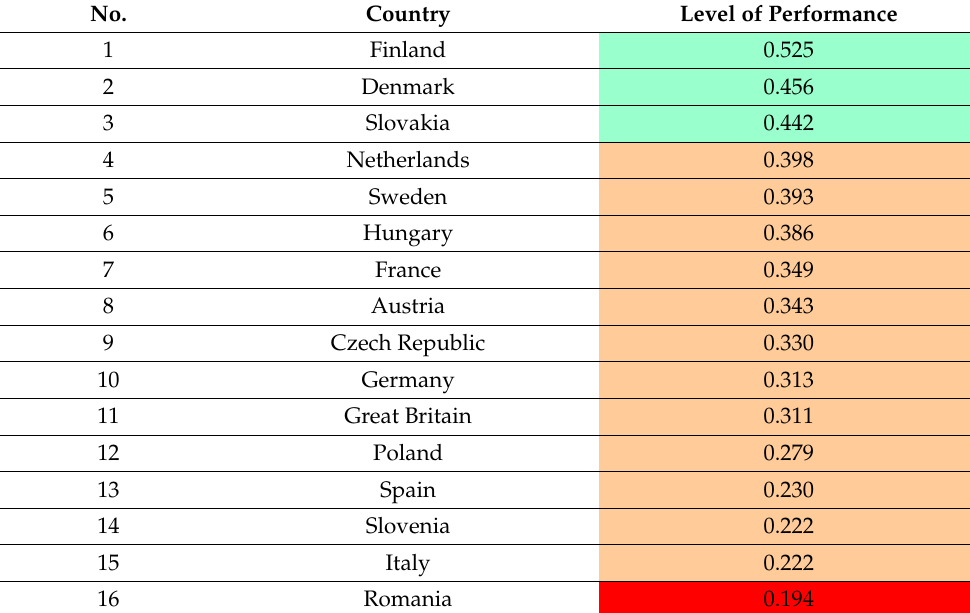
Table 7. Country ranking based on the level of performance in the bioenergy